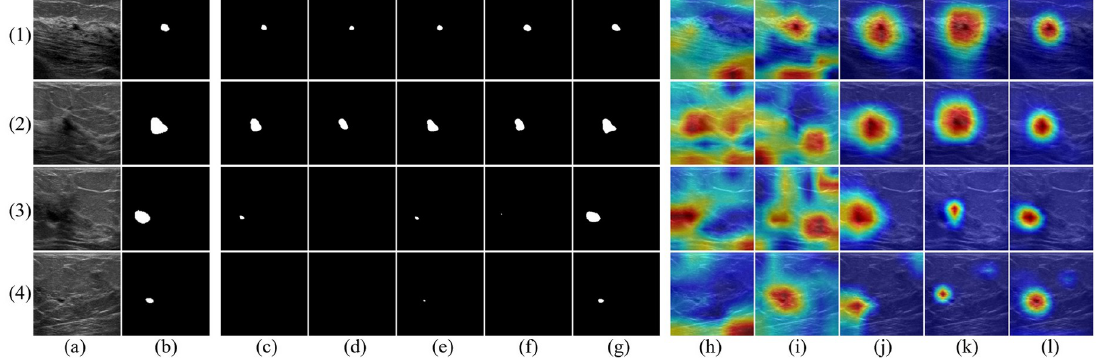
Fig 9. Visualization of segmentation results and class activation maps for the BUS image private dataset. (a) BUS images; (b) ground truth (white areas are lesions); (c)–(g) segmentation results are achieved, by U-Net, Attention U-Net, Nested U-Net, MA U-Net, CTG-Net (ours), respectively; (h)–(l) class activation maps are achieved by AlexNet, VGG16, ResNet18, DenseNet121, and CTG-Net (ours),